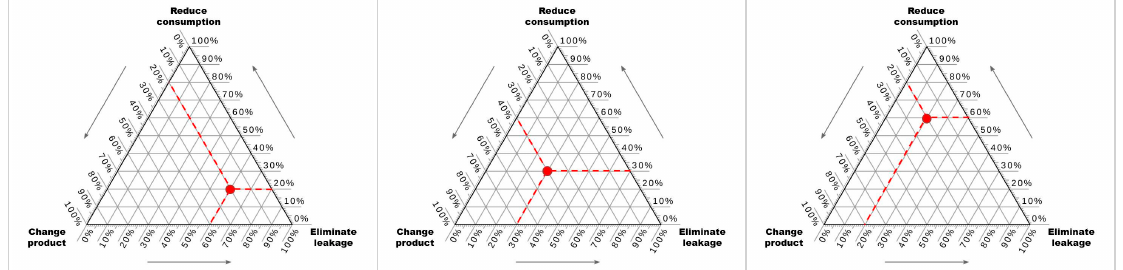
Figure 4. Ternary plot of various localised responses to waste plastic leakage into the environment For a country like South Africa, where only 61.0% of households receive a weekly waste collection service [16], the solution is likely to lie in a combination of: (i) improved waste collection; (ii) select product replacement to bio-benign, where it is unlikely to ever be economically viable to recycle certain products at end-of-life; and, if still needed, (iii) regulatory intervention to force the shift.